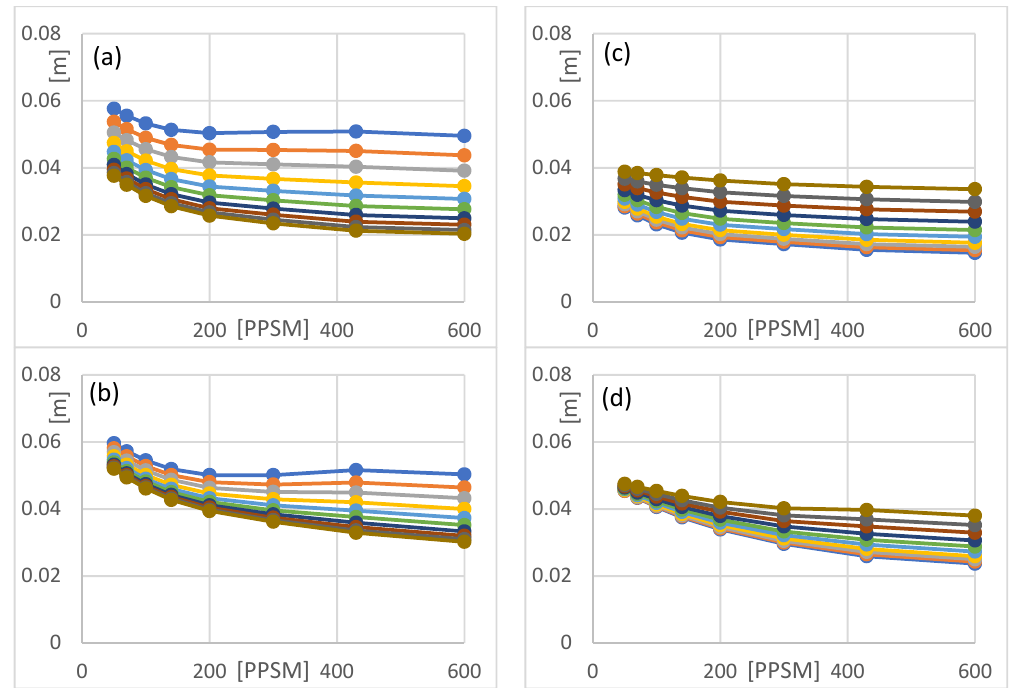
Figure 11. Selected examples of simulated external uncertainty. ( a ) x-uncertainty, 2 m × 2 m, 2 PPSM, ( b ) z-uncertainty, 2 m × 2 m, 2 PPSM, ( c ) x-uncertainty, 4 m × 4 m, 16 PPSM, ( d ) z-uncertainty, 4 m × 4 m, 16 PPSM. The curves in all plots represent varying TPU; from top curve (10 cm TPU) to bottom curve (3 cm TPU).